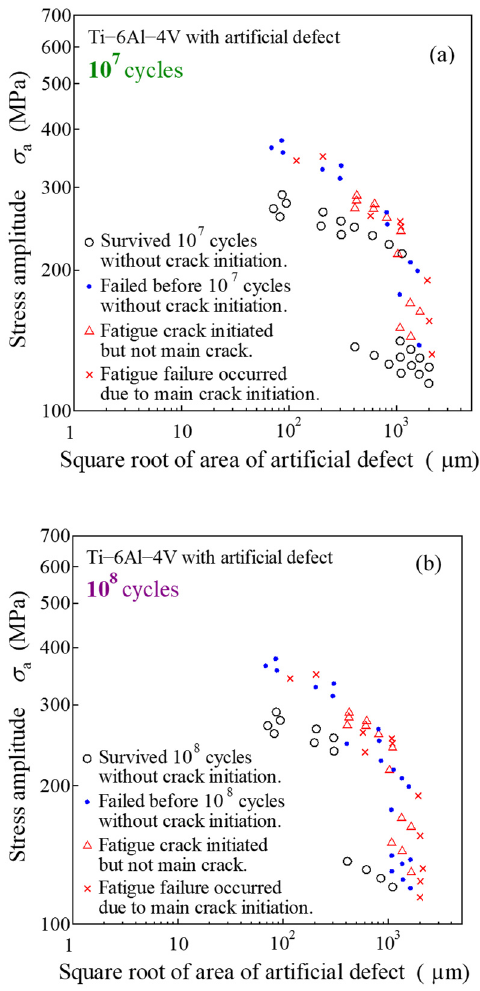
Figure 8. Relationship between stress amplitude and √ area of the defect; ( a ) 10 7 cycles, ( b ) 10 8 cy-